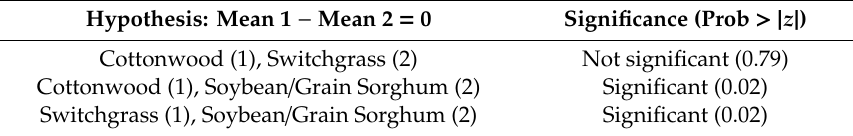
Table 6. Statistical analysis of average carbon emissions from activities for all three sites.